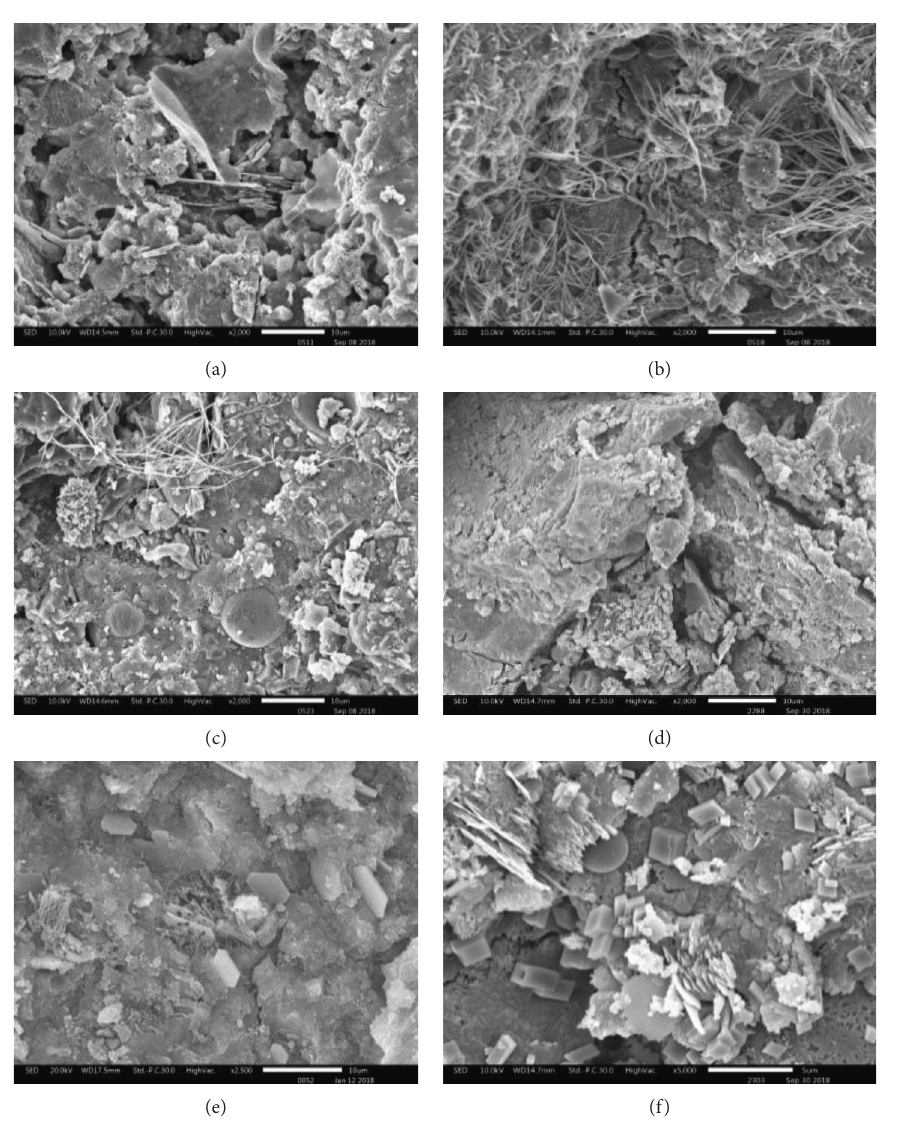
Figure 7: SEM images of mortar samples at 7 and 28d. CSS: standard mortar; CCS: coral mortar; CFSCS: coral mortar with 15% fly ash and 15% slag.